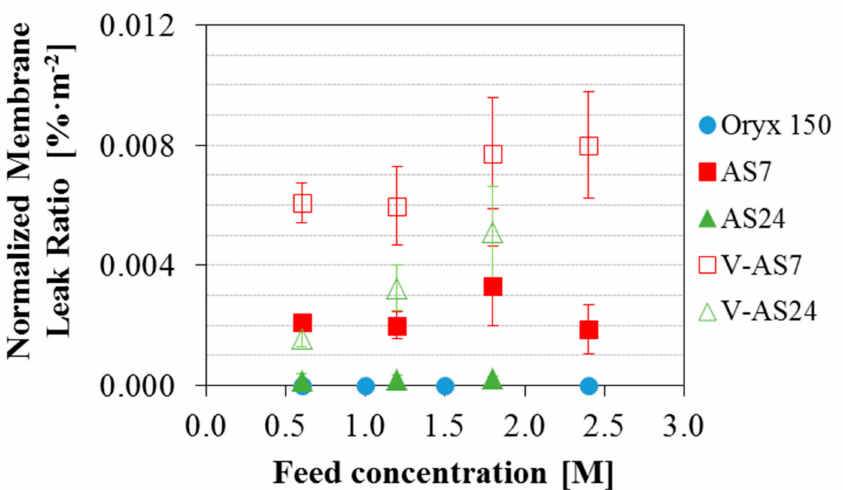
Figure 7. Normalized Membrane Leak Ratio obtained with the Oryx 150, the AS7 and the AS24 modules (in AGMD and V-AGMD configuration) for di ff erent initial feed concentrations. T hot = 80 ◦ C; T cold = 25 ◦ C; F = 1100 L · h − 1 (AS modules) and 600 L · h − 1 (Oryx